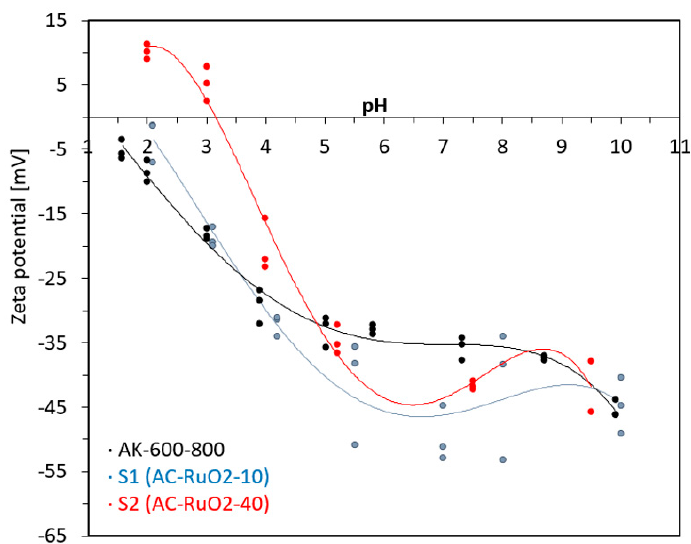
Figure 3. Zeta potential values at different pH-values for AC (AC-600-800), S1 (AC-RuO2-10) and S2 (AC-RuO2-40) (IFKB, University of Stuttgart). (AC-RuO 2 -40) (IFKB, University of